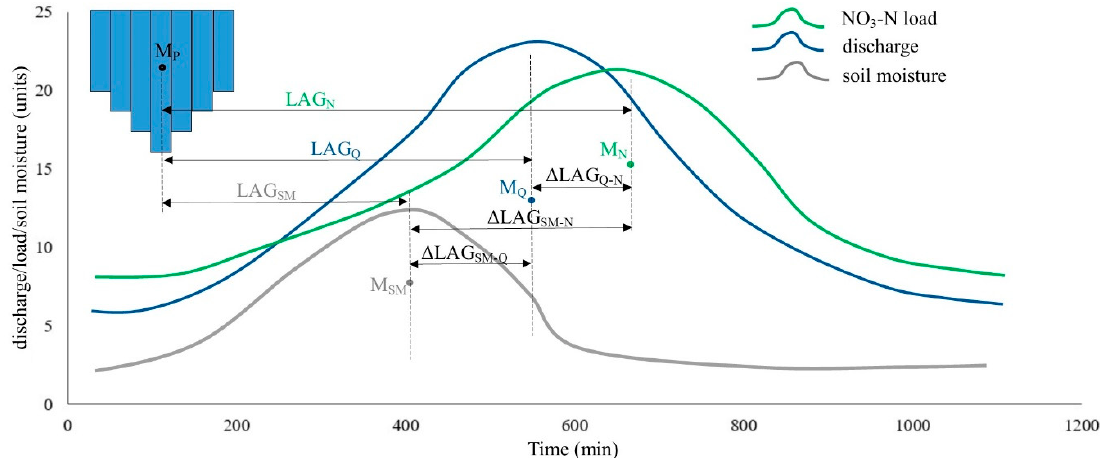
Figure 4. Conceptual representation of individual lag times used in this study, where green, blue, and grey lines represent temporal change of nitrate-nitrogen load, discharge, and soil moisture, respectively.